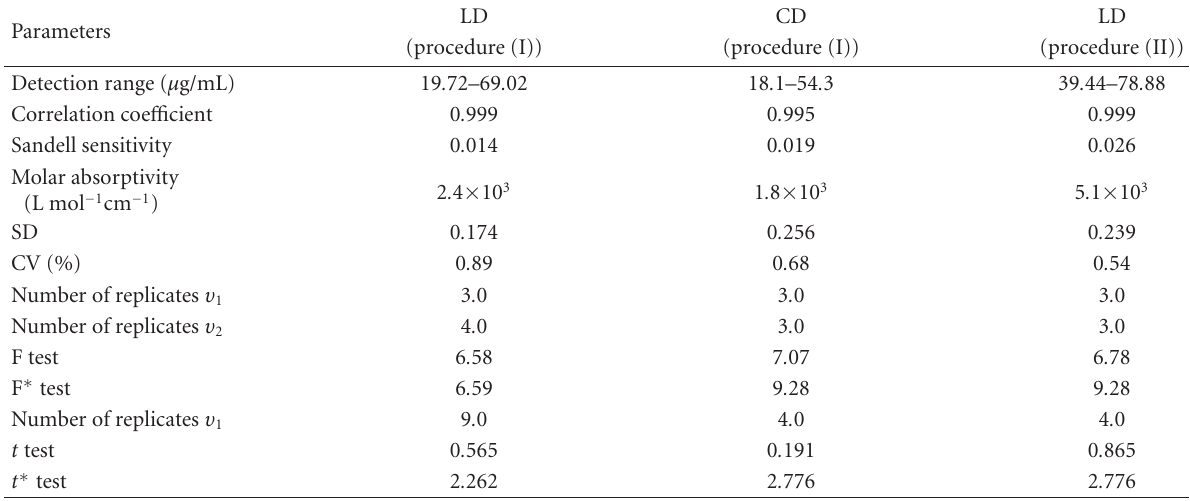
Table 1. Statistics for the recovery of LD and CD with copper (II) complex and 4-AAP, and LD with I − 3 .